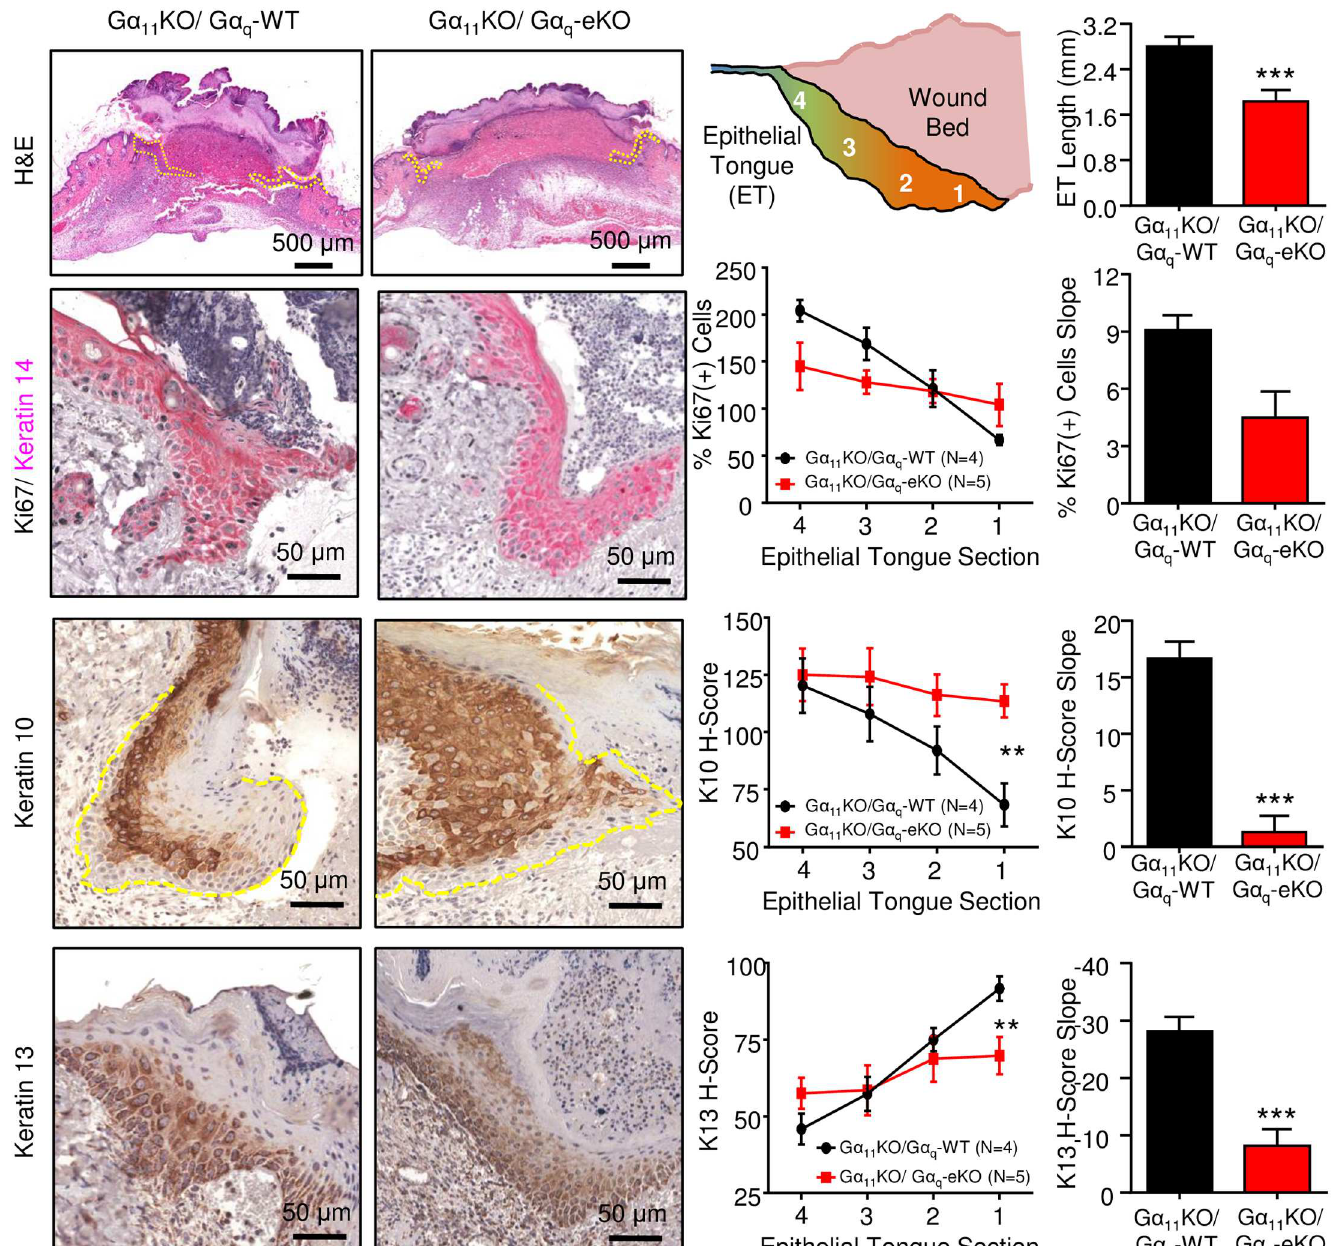
Fig 5. Loss of epidermal G α q correlateswith defects in reepithelialization of cutaneous wounds. Top panel: the epithelialtongueas evidencedby H&E staining (yellowdashedline) is diagrammedand the length quantified.Representative stains and quantification of Ki67 (secondpanel), K10 (third panel), and K13 (bottom panel)are shown. All quantifications are based on an N = 4 mice per group and proliferation is shown relative to normaladjacent epithelium. Slope was determined by linear regressionand statistical significancewas determined by Student’st-test, p < 0.05, ** p < 0.01, *** p < 0.001.